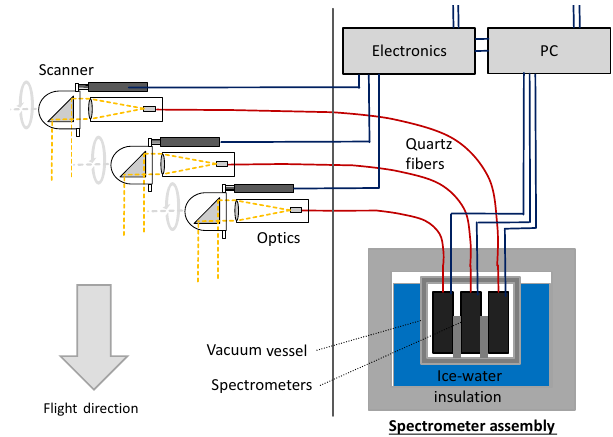
Figure 1. Sketch of the mini-DOAS instrument, as developed for NASA’s Global